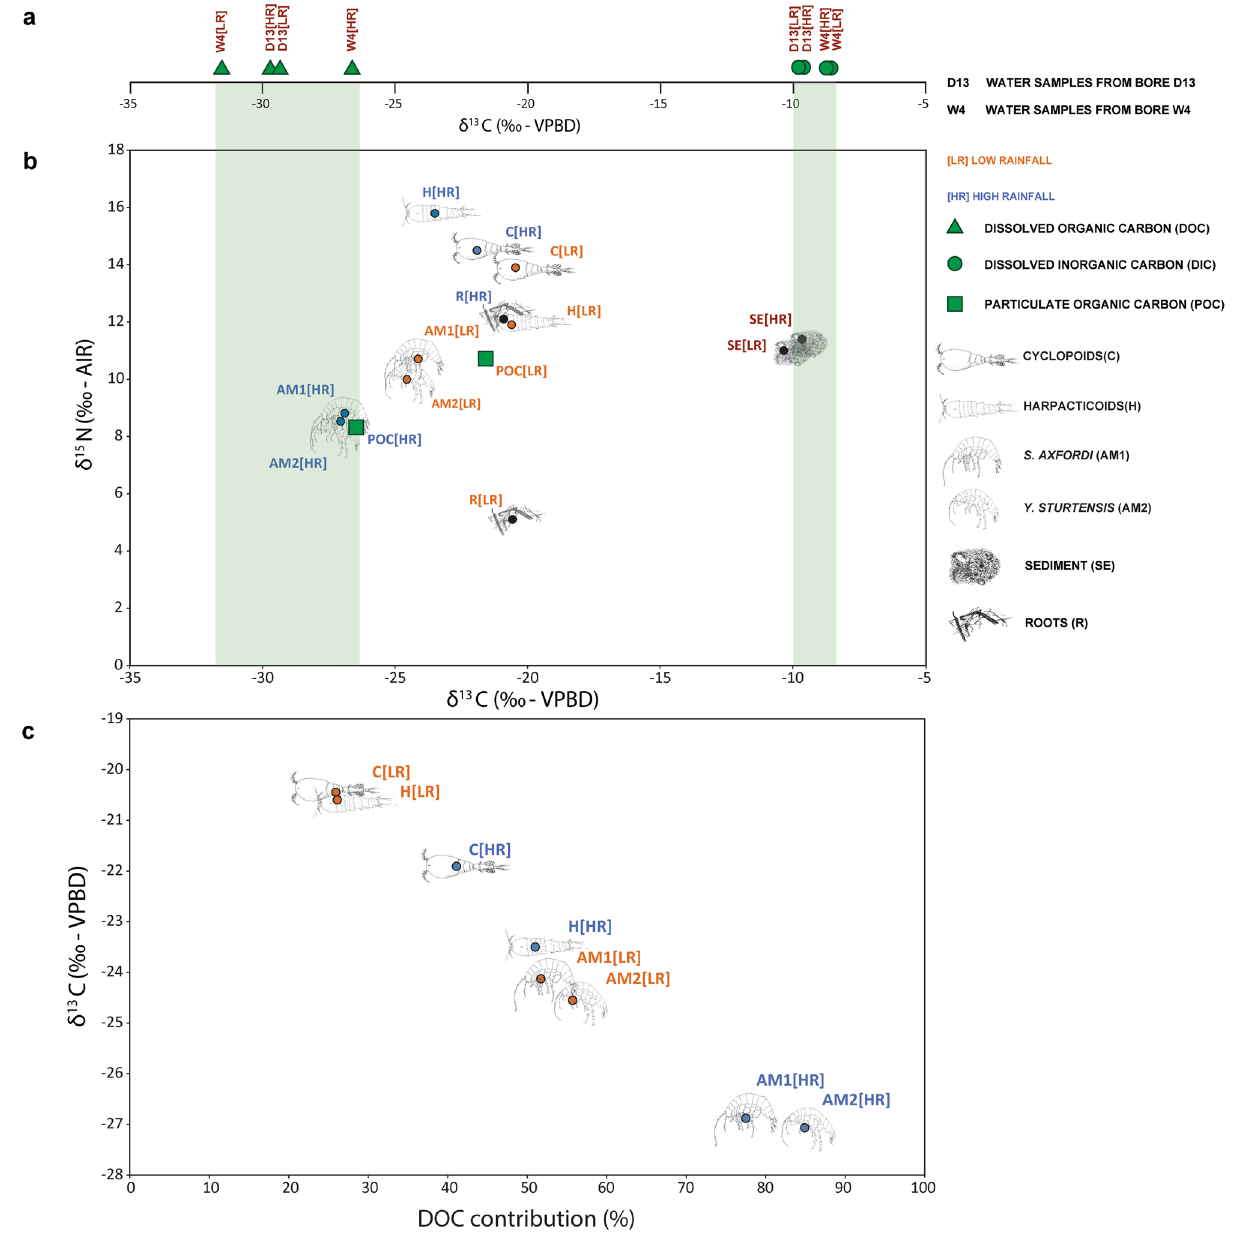
Figure 3. Isotopic patterns amongst primary and secondary consumers and their carbon sources. ( a ) δ 13 C DOC and δ 13 C DIC from the bores W4 and D13 (during LR and HR) and their ranges (in light green) incorporated in graph ( b ), which illustrates the δ 13 C and δ 15 N for LR (low rainfall) and HR (high rainfall) of roots, sediment, POC (particulate organic matter), copepods (C and H) and amphipods (AM1 and AM2); VPBD: Vienna Pee Dee Belemnite; AIR: N 2 of atmospheric air; in red the old (considering present as 1950) carbon sources revealed by radiocarbon dating (refer to Table 1 for specific values). ( c ) Estimation of DOC contributions for the diets of copepods (C and H) and amphipods (AM1 and AM2) during LR and